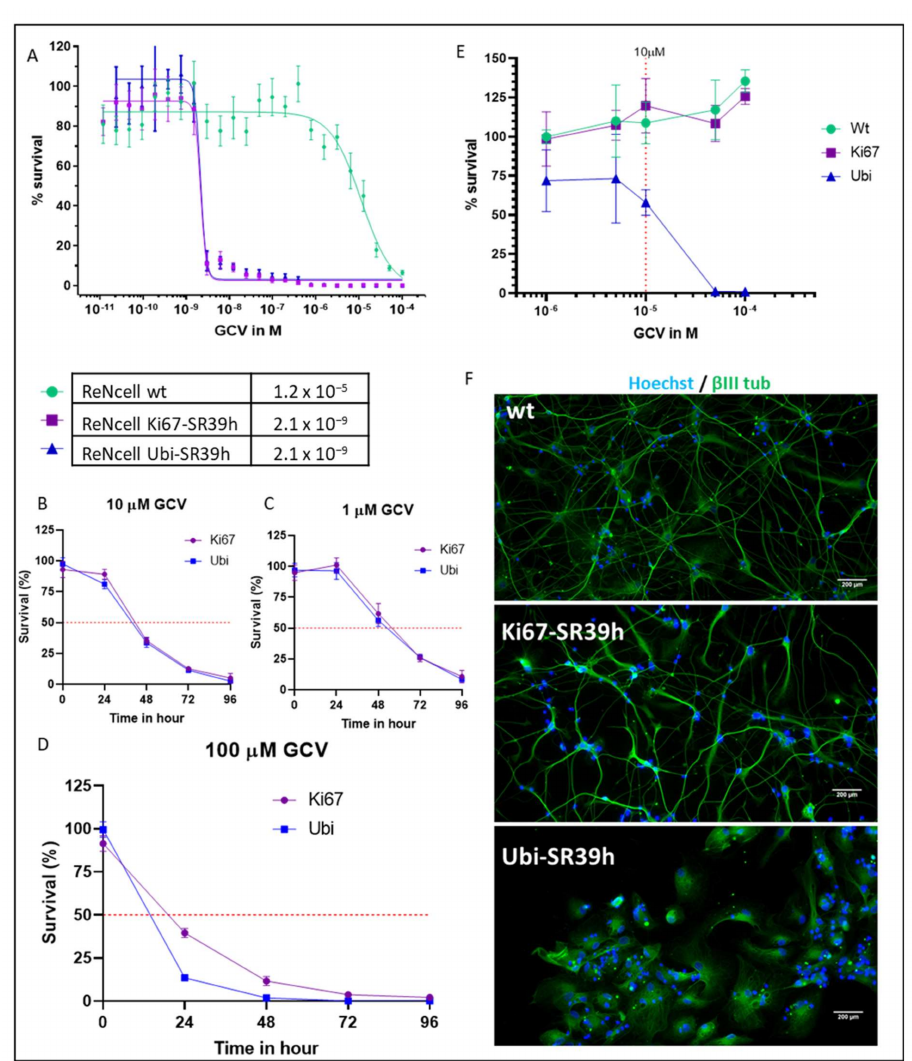
Figure 4. EC50 and kinetics of GCV-induced cell death in proliferating and post-mitotic ReNcells. SR39h was expressed in ReNcells (immortalized neural precursor cells that can be differentiated to post-mitotic neurons) under the control of the two different promoters: Ki67 or ubiquitin. Wild type ReNcells were used as control. ( A ) Dose response of GCV in proliferating neural precursor cells after 96 h of drug exposure, EC50 were expressed in M. Bioluminescent ATP-based assays were performed, and 24-point dose response curves were generated ( n = 3). ( B – D ) Kinetics of cell death of SR39-expressing ReNcells cells either under the control of cycle promoter Ki67 or ubiquitin promoter with increasing GCV concentrations of 1, 10, and 100 µ M. Cell viability was measured every 24 h using a bioluminescent ATP-based assay ( n = 3). ( E ) ReNcells were differentiated